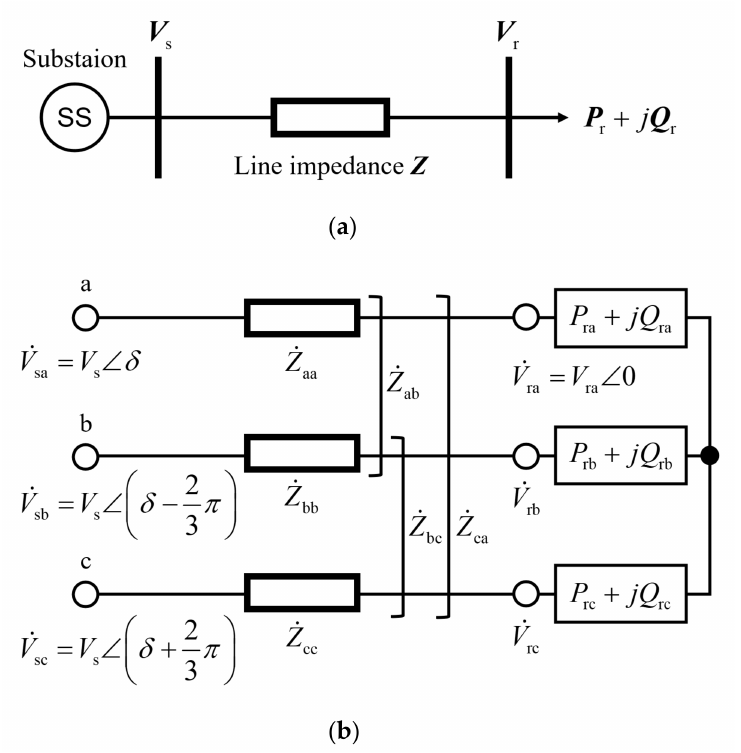
Figure 4. Simplified distribution system model: ( a ) single-line diagram; ( b ) three-phase circuit